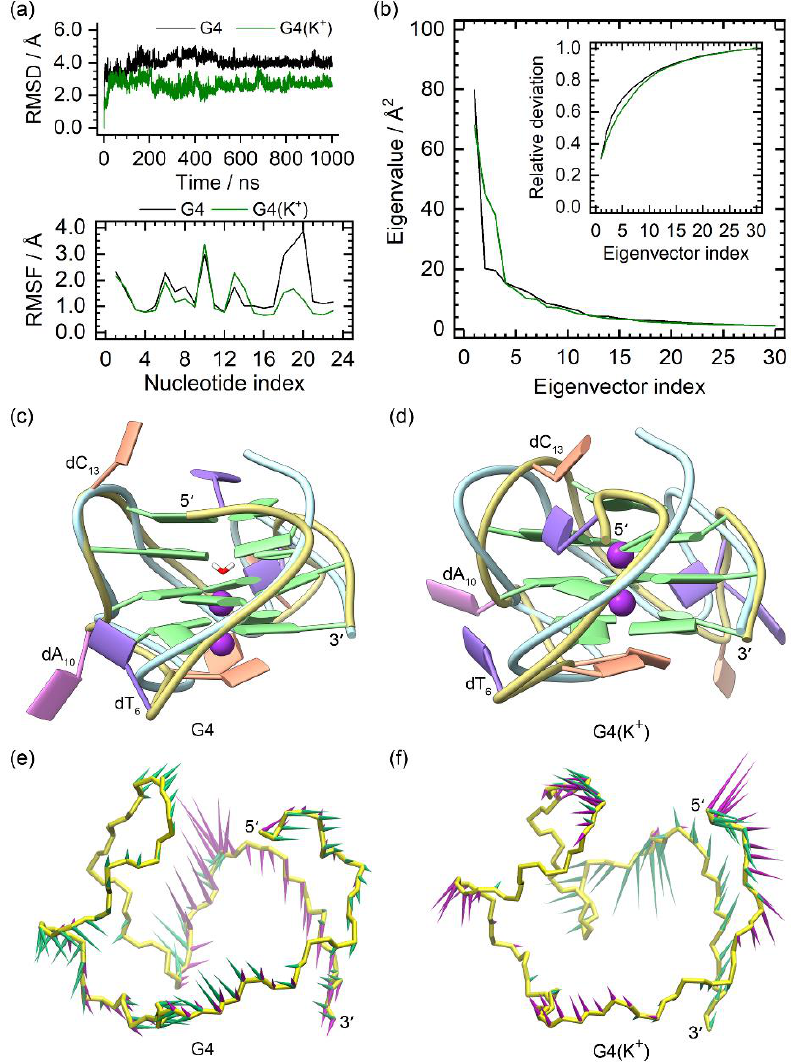
Figure 2. Characteristics of the apo G4 and G4(K + ). ( a ) root-mean-square deviation (RMSD) and root-mean-square fluctuation (RMSF) profiles of the apo G4 and G4(K + ); ( b ) eigenvalue profiles constructed by the first 30 eigenvectors of G4 (black) and G4(K + ) (green) in PCA analysis; ( c , d ) superposition of the MD-equilibrated and the NMR structures of PARP1 G4 and G4(K + ). The central K + ions in G4(K + ) are shown as purple spheres. For clarity, the NMR structures are shown as light-blue ribbons; ( e , f ) porcupine plots of the dominant motions along the first (green) and the second (magenta) eigenvectors of PARP1 G4 and G4(K + ). The direction and size of the colored arrows represent the directions and extents of the principal motions of G4/G4(K + ) backbone atoms along the given